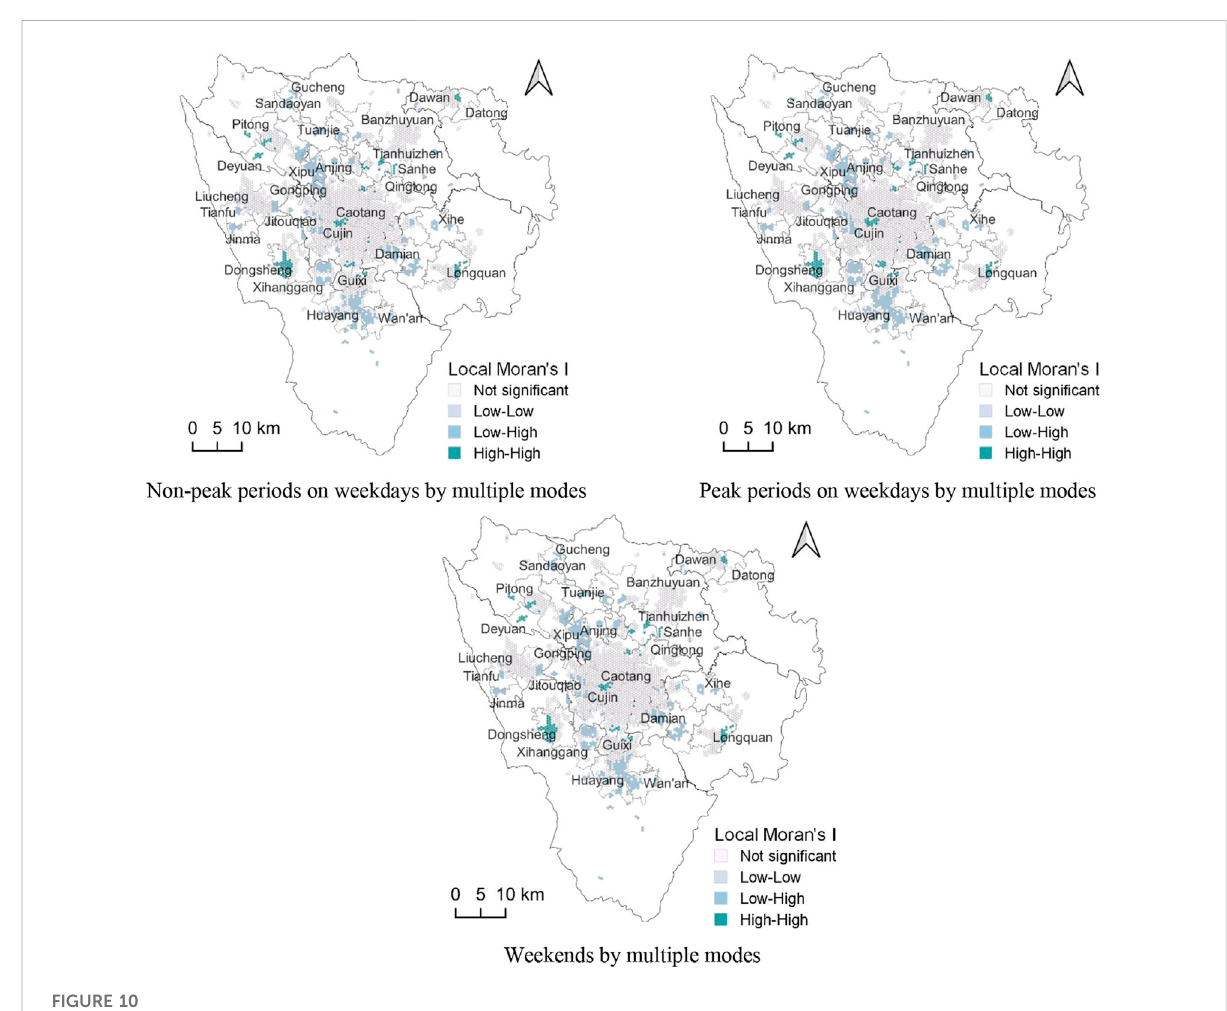
FIGURE 10 Partial clustering of park accessibility by multiple modes in three